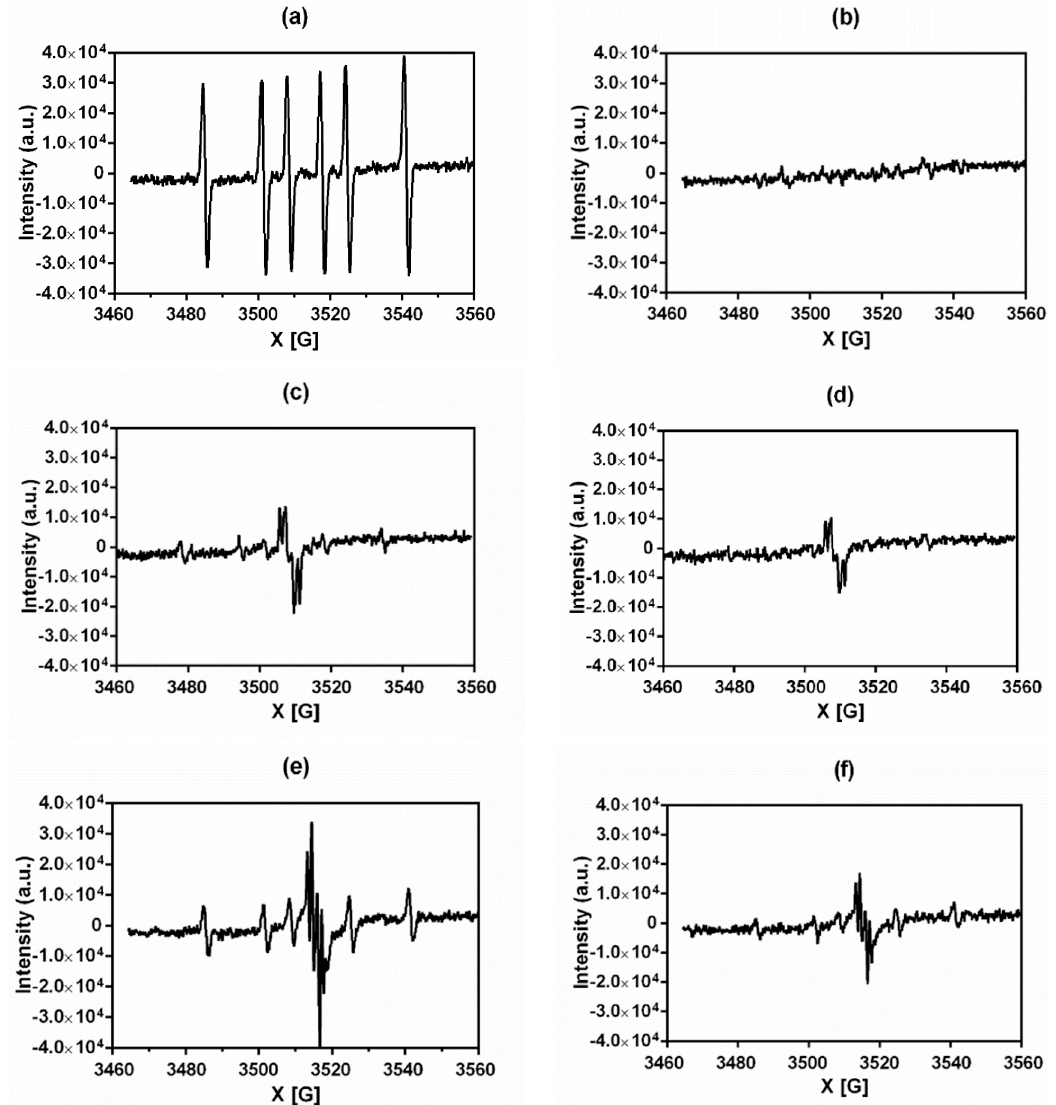
Figure 2. EPR spectra: Free radicals produced by NQO2 metabolism of selected compounds. ( a ) menadione, ( b ) menadione + S29434, ( c ) Compound 1 , ( d ) Compound 1 + S29434, ( e ) Compound 3 , and ( f ) Compound 3 + S29434. Table 1. Capacity of the compounds to form reactive oxygen species after metabolism by NQO2. Compound ROS after NQO2 Reduction ROS after Inhibition of NQO2 with S29434